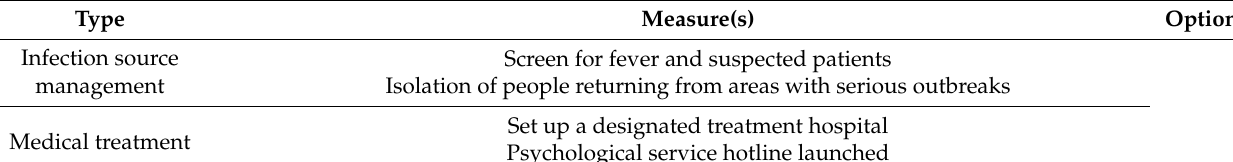
Table 1. Measures of government